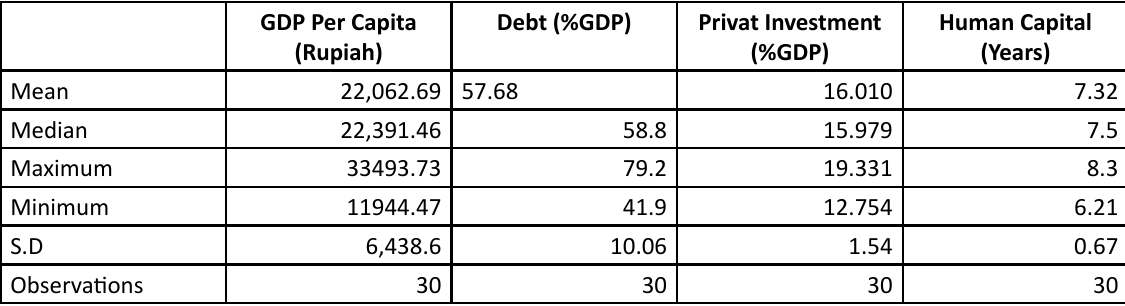
Table 3B: Descriptive Statistics - Growth Model Variables - The Philippines